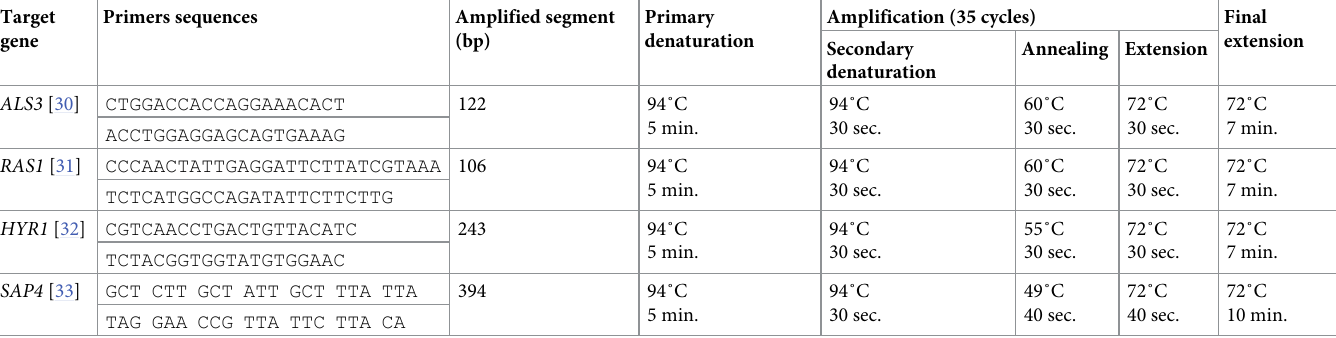
Table 1. Primers sequences, target genes, amplicon sizes and cycling conditions. Target